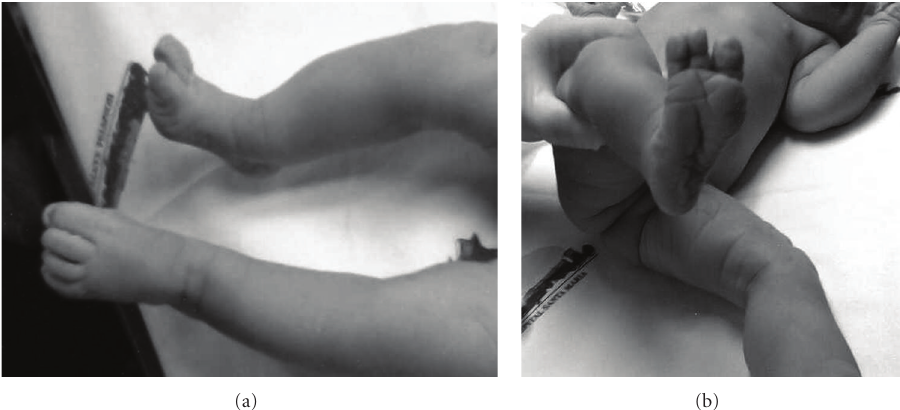
Figure 3: Neonatal pediatric examination at the 1st postnatal day: right limb shortening and bowing (a) and right foot with three digits (b).